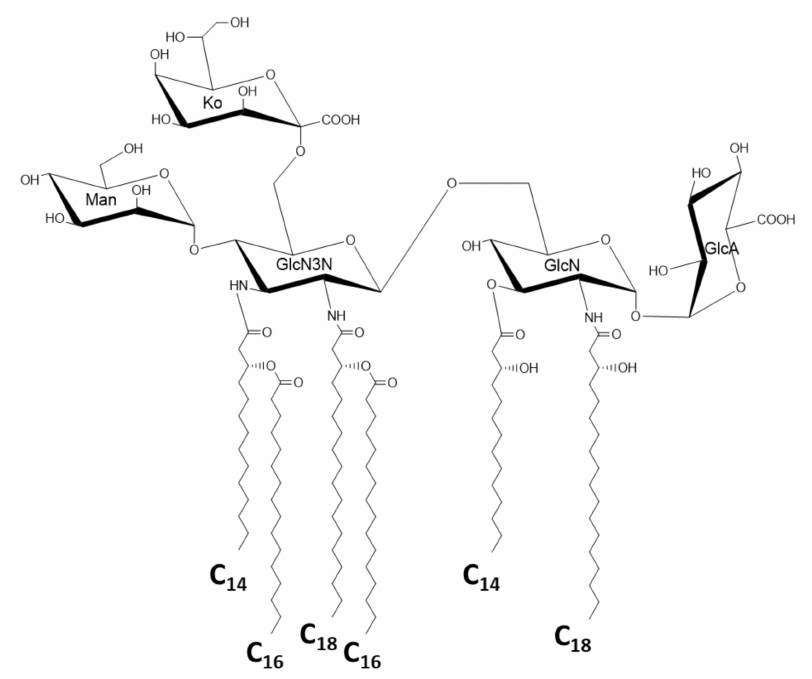
Figure 5. Chemical structure of Rhodobacter sphaeroides lipid A ( a ) and Eritoran ( b ) developed as an antagonist of endotoxin based on the structure of R. sphaeroides lipid A.